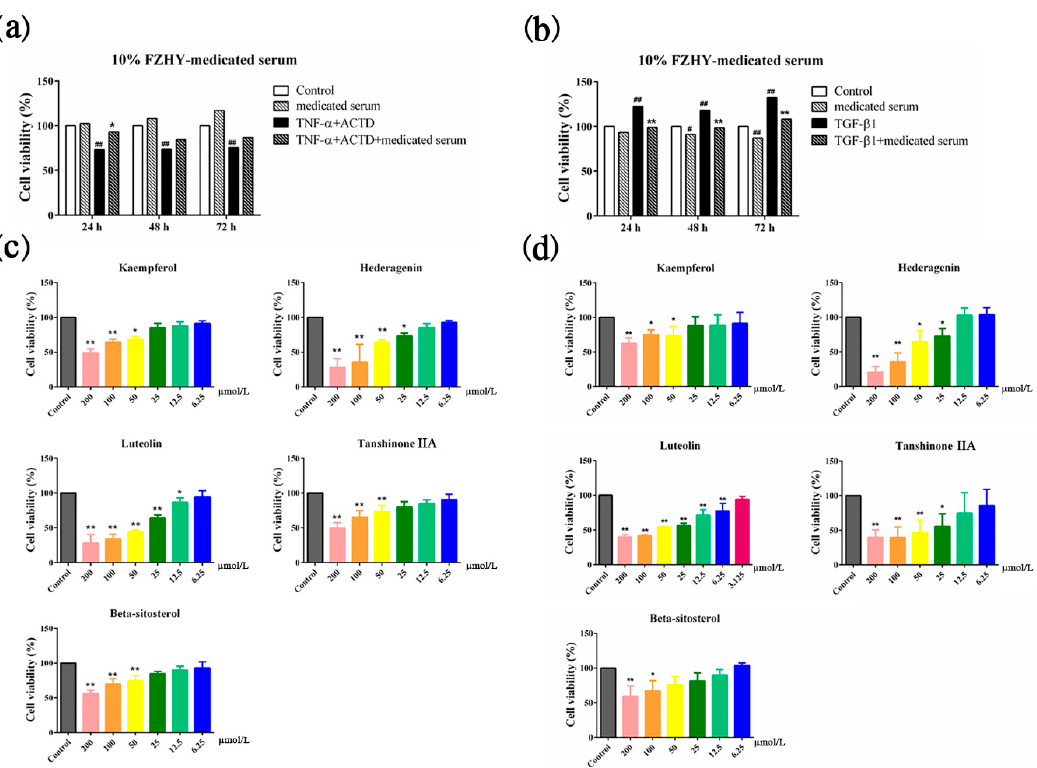
Figure 3. ( a ) Effects of FZHY-medicated serum on L02 cells viability at 24, 48, and 72 h. ( b ) Effects of FZHY-medicated serum on Lx2 cells viability at 24, 48, and 72 h. # p < 0.05, ## p < 0.01, compared with the control group. * p < 0.05, ** p < 0.01, compared with the TNF- α + ACTD or TGF- β 1 group. ( c ) Effects of kaempferol, hederagenin, luteolin, tanshinone IIA and beta-sitosterol on L02 cells viability at 24 h. ( d ) Effects of kaempferol, hederagenin, luteolin, tanshinone IIA and beta-sitosterol on Lx2 cell viability at 24 h. FZHY, FZHY formula. * p < 0.05, ** p < 0.01, compared with the control group. Repeated 4